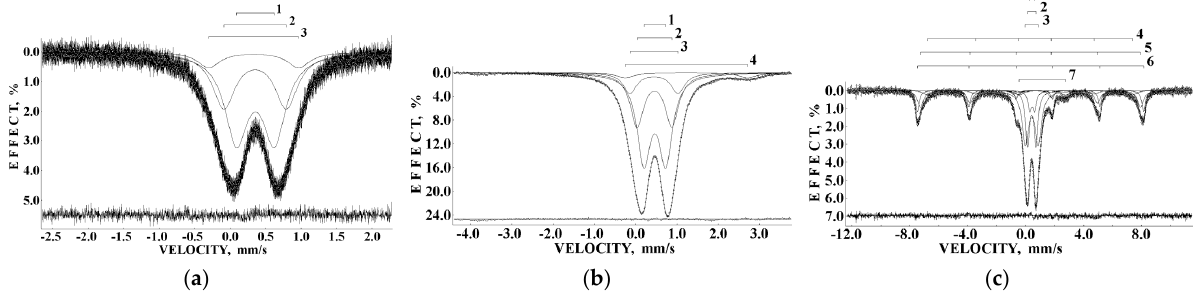
Figure 22. Mössbauer spectra of lyophilized Imferon at 295 K ( a ), initial Imferon in frozen solution at 87 K ( b ) and Imferon in frozen solution measured 10 years after sample ( b ) at 90 K ( c ). Indicated components in the spectra ( a , b ) are the results of the best fits within the new heterogeneous model for the iron core with equal line width for three components 1–3 assigned to the iron cores and residual FeCl 2 (4) while the spectrum ( c ) was fitted with 7 component using an old heterogeneous iron core model with free variation of parameters (all parameters are given in Table 1). The differential spectra are shown on the bottom. ( b , c ) were adapted from Ref. [41] with permission from Elsevier: Journal of Molecular Structure, Vol. 993, Oshtrakh M.I., Alenkina I.V., Dubiel S.M., Semionkin V.A., “Structural variations of the iron cores in human liver ferritin and its pharmaceutically important models: